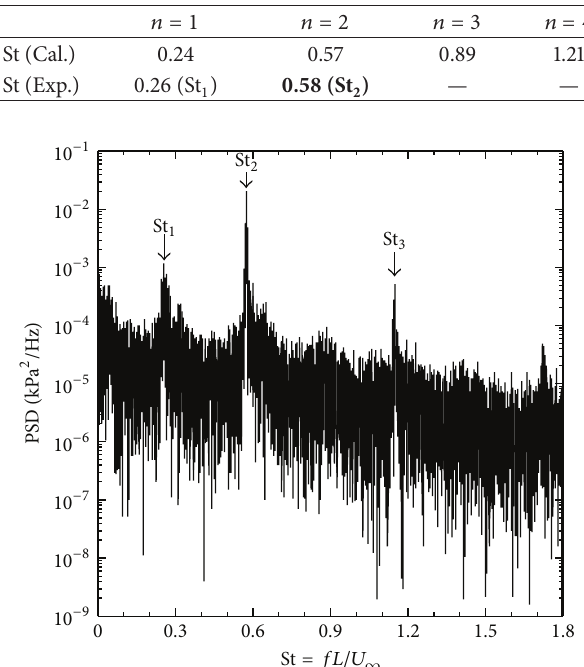
Figure 3: Power spectral density of pressure oscillation for 𝐿/𝐷 = 2.8 .